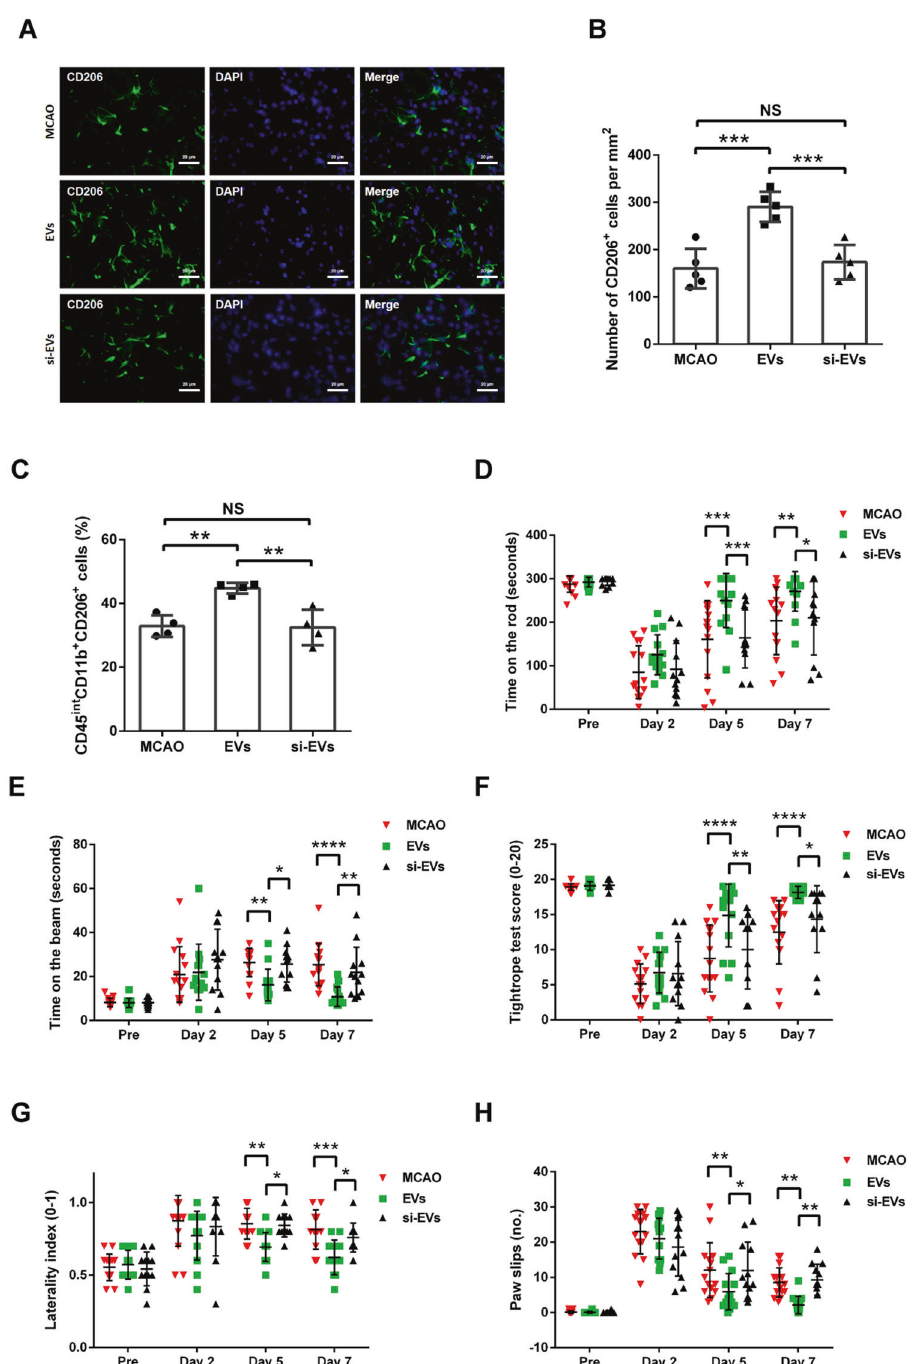
Fig. 6 Delivery of TGF- β 1-enriched EVs augments M2 polarization of microglia and mitigates postischemic motor coordination impairment in stroke mice. A , B Quantitative analysis of M2 polarization of microglia cells (CD206, green) in the ischemic striatum at post- MCAO day 7 by immuno fl uorescence staining in the three groups: MCAO control, MCAO with EV treatment, and MCAO with si-EV treatment. EV infusion increases M2 polarization rates of resident microglial cells in the ischemic striatum compared with the si-EVs group ( n = 5). C At post-MCAO day 7, fl ow cytometry of ischemic hemispheres showing a signi fi cant increase of M2 microglial cells (CD45 int CD11b + CD206 + ) in the EV treatment group compared to the MCAO control and the MCAO si-EV treatment group ( n = 4). Delivery of EVs reduces postischemic motor coordination impairment. Motor coordination was evaluated using the rotarod test ( D ), balance beam test ( E ), tightrope test ( F ), corner turn test ( G ), and paw slips recording ( H ) 1 day before stroke (pre) as well as 2, 5 and 7 days after stroke. All animals were accordingly trained before the induction of stroke in order to ensure proper test performance ( n = 5). Data are expressed as mean ± SD. NS no signi fi cance, * p < 0.05, ** p < 0.01, and *** p < 0.001. EVs extracellular vesicles, MCAO middle cerebral artery